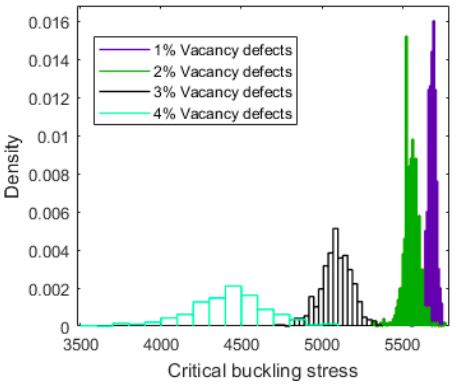
Figure 4. Comparison of the probability density for graphene sheets with different amounts of vacancy defects.